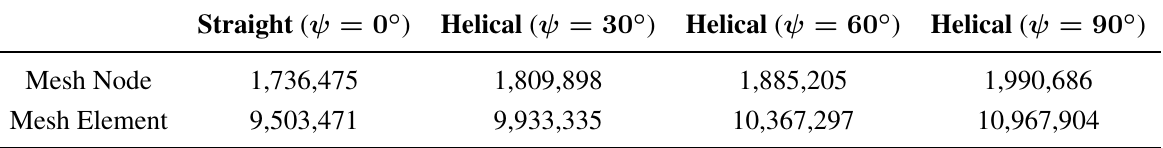
Table 3. Number of three-dimensional grid nodes and